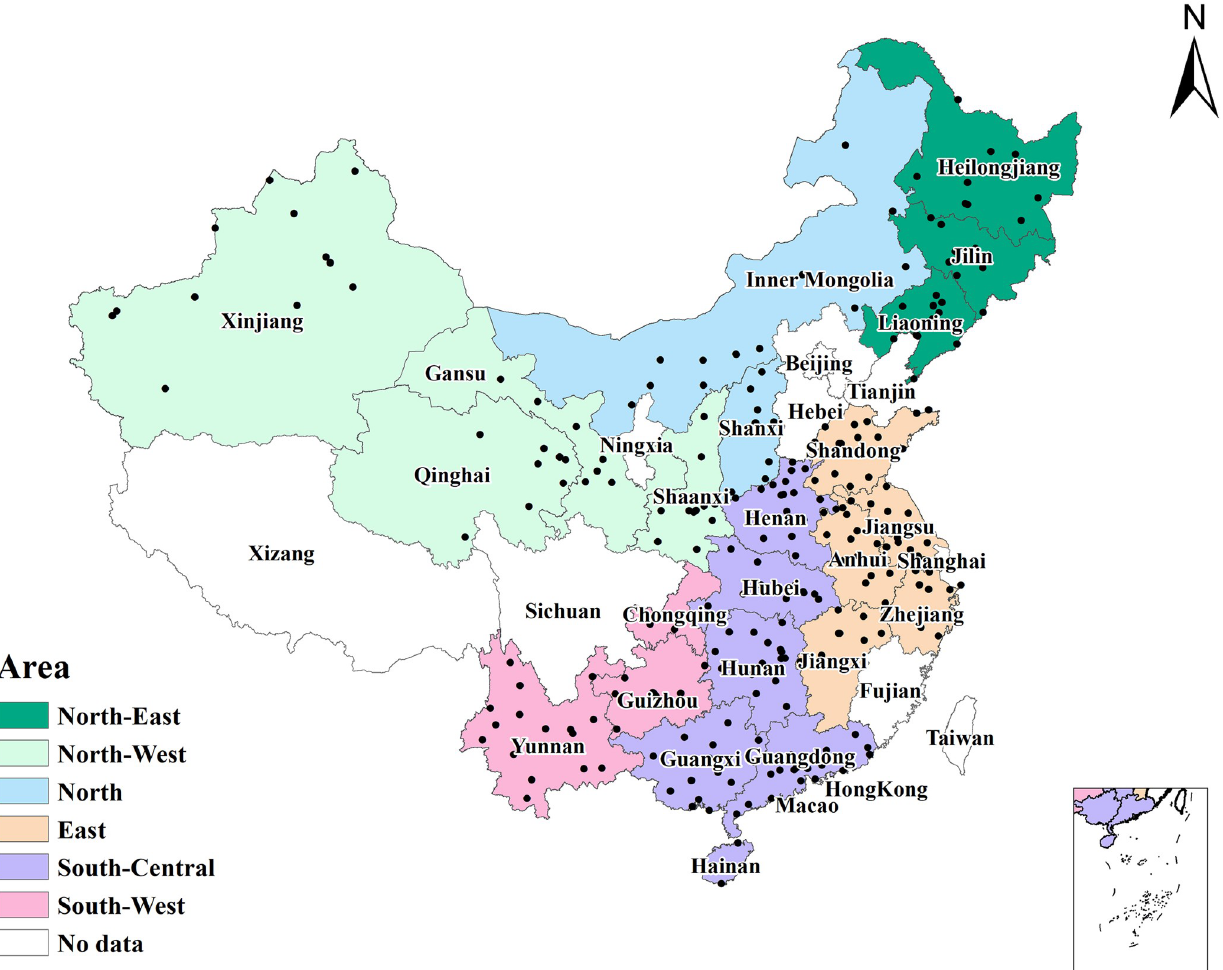
Fig 1. The 23 provinces in China included in the study. The geographical base map data were obtained from the Institute of Geographic Sciences and Natural Resources Research, Chinese Academy of Sciences (http://www.resdc.cn/). Black dots indicate the included cities in 23 provinces.